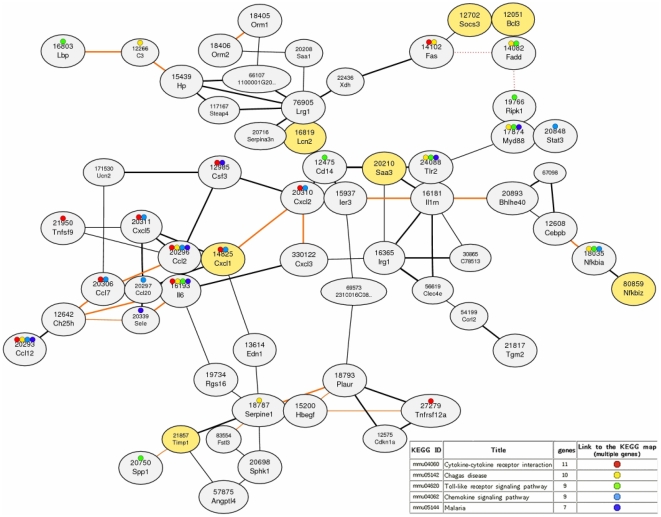
Co-expression network for highly correlated gp130 dependent genes.The co-expression network is drawn based on gene expression correlation patterns (Mutual rank scores) for the 8 candidate genes using the Coxpresdb tool [10]. A bold line indicates a high co-expression between the genes. Orange lines indicate genes co-expressed in mouse and men. Red dotted lines indicate protein-protein interactions.